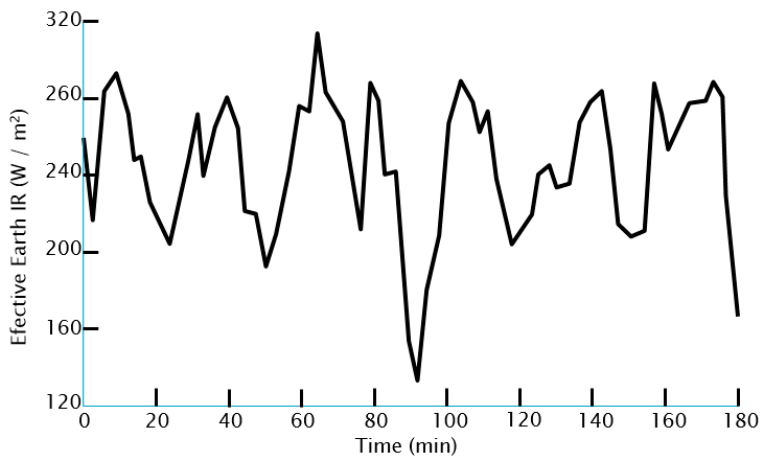
Figure 47. Fluctuations in Earths IR Output throughout an Orbit Cycle [64].